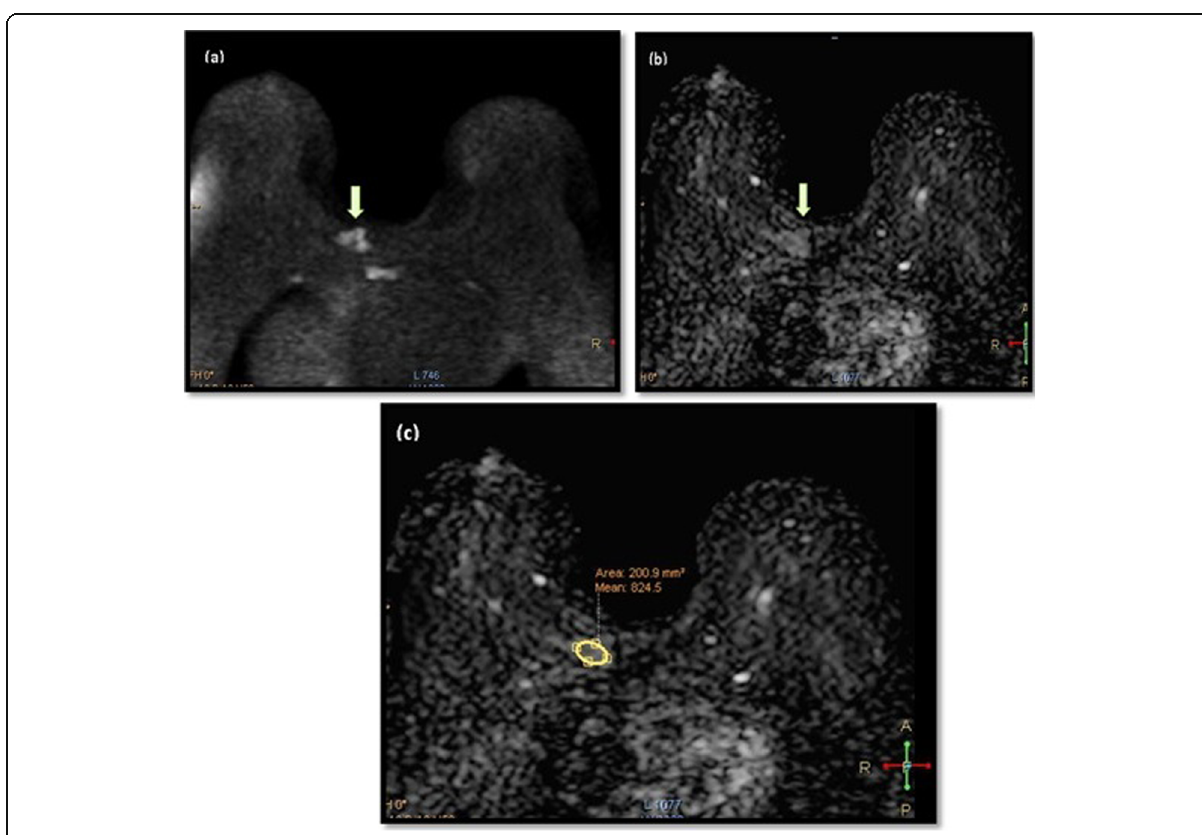
Fig. 1 DWIs analysis. a DWI at b 1500 and b ADC map c ADC value: 0.82 × 10 − 3 mm2/s. The right breast lower inner mass showed restricted diffusion of persistent bright SI on DWI and intermediate SI on ADC map with an estimated ADC value of 0.82 × 10 − 3 mm 2 /s. Pathology